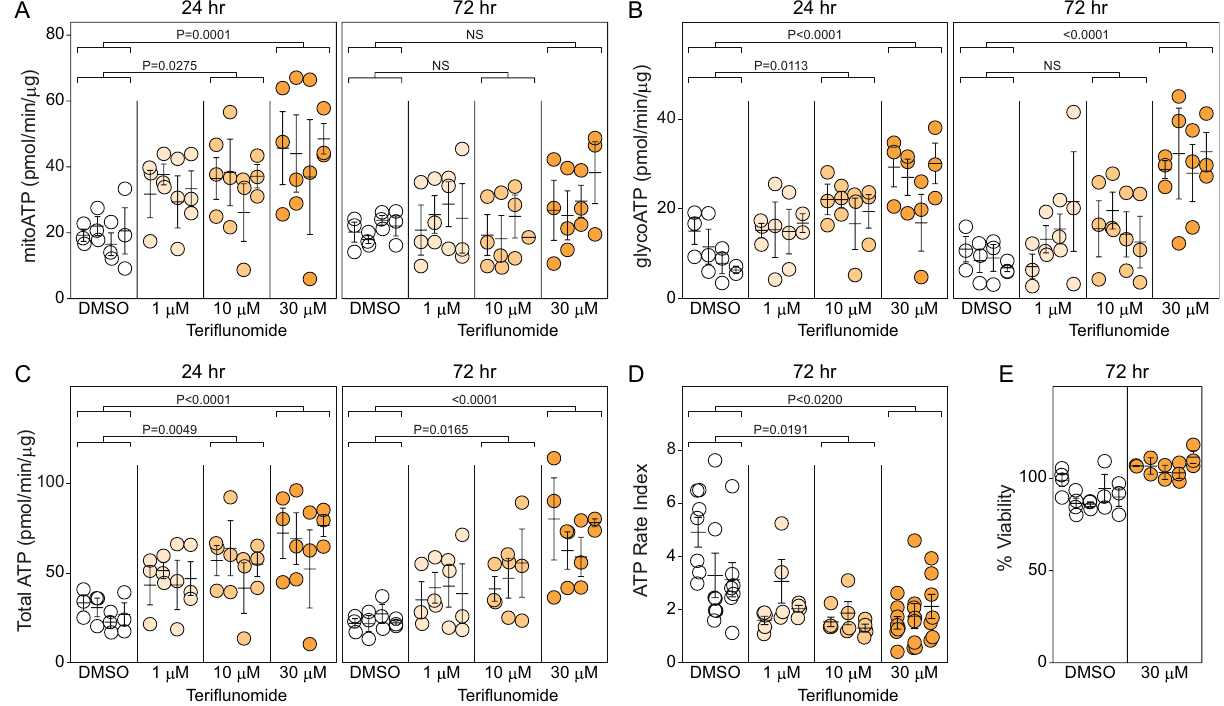
Figure 4. Teriflunomide increases glycolysis in quiescent astrocytes. Astrocytes grown under serum-free conditions were treated with teriflunomide (1, 10, 30 μM) under two paradigms. In the first, cells were incubated for 24 h. In the second, cells were treated once, then again after 48 h, and analyzed 24 h later (72 h total). Mitochondrial ATP production rate ( A ), glycolytic ATP production rate ( B ), and total ATP production rate ( C ) were measured using the Seahorse XF analyzer. Data are normalized to total protein (μg) per well. Each symbol represents one well from 3 separate experiments, shown in nested layout. Mean ± SEM is shown for each biological replicate. P-values were calculated using mixed model nested ANOVA between treatment conditions. ( D ) The ratio of mitochondrial ATP production rate to glycolytic ATP production rate was calculated from the data in ( A ) and ( B ) to indicate the ATP rate index in the 72 h paradigm. Each symbol represents one well from 3 separate experiments, shown in nested layout. Mean ± SEM is shown for each biological replicate. P-values were calculated using mixed model nested ANOVA between treatment conditions. ( E ) Viability of astrocytes exposed to teriflunomide (30 μM) in the 72 h paradigm was measured by MTT assay. Data are normalized to vehicle- only. Each symbol represents one well from 3 separate experiments, shown in nested layout. Mean ± SEM is shown for each biological